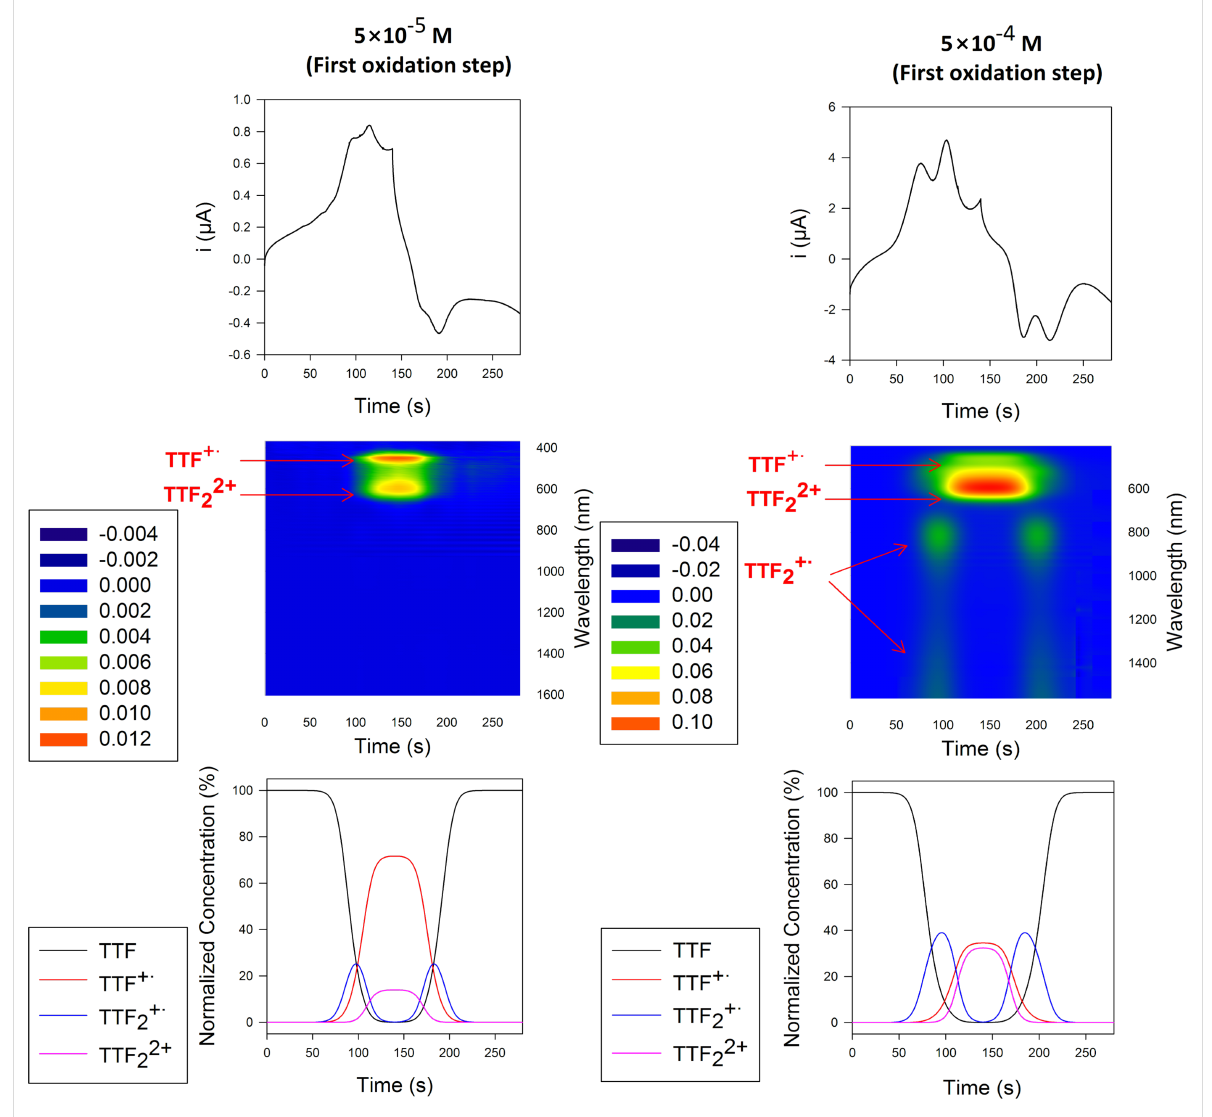
Figure 6: Spectroelectrochemical experiment of molecular clip 1 during the first oxidation step at different concentrations (left: 5 × 10 − 5 M; right : 5 × 10 − 4 M) in 0.1 M TBAPF 6 /CH 2 Cl 2 /CH 3 CN (3:1) on glassy carbon on Pt electrode in thin layer conditions (close to 50 µm) electrode at 5 mV·s − 1 and 293 K. (top) CV in current vs time representation. (middle) 3D representation: x -axis = wavelength, y -axis = time and z -axis = absorbance. (bottom) concentration-time profiles of each simulated species in the thin layer (50 µm) calculated from electrochemical simulations of Figure 4 ( E 1 = 0.090 V, E 2 = 0.165 V, E 3 = 0.435 mV, K MV = 11400 M − 1 , K DIM = 680 M − 1 , k f = 1 × 10 9 M − 1 ·s − 1 for all the forward reactions, α = 0.5 and k s = 0.01 cm·s − 1 for all the charge